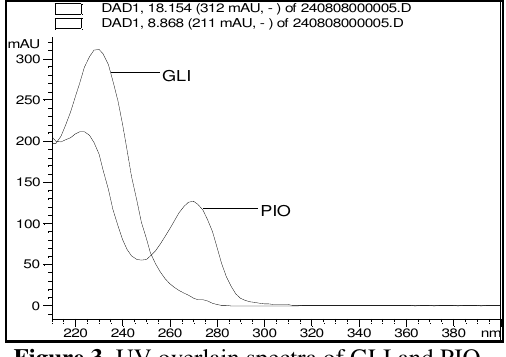
Figure 3 . UV overlain spectra of GLI and PIO